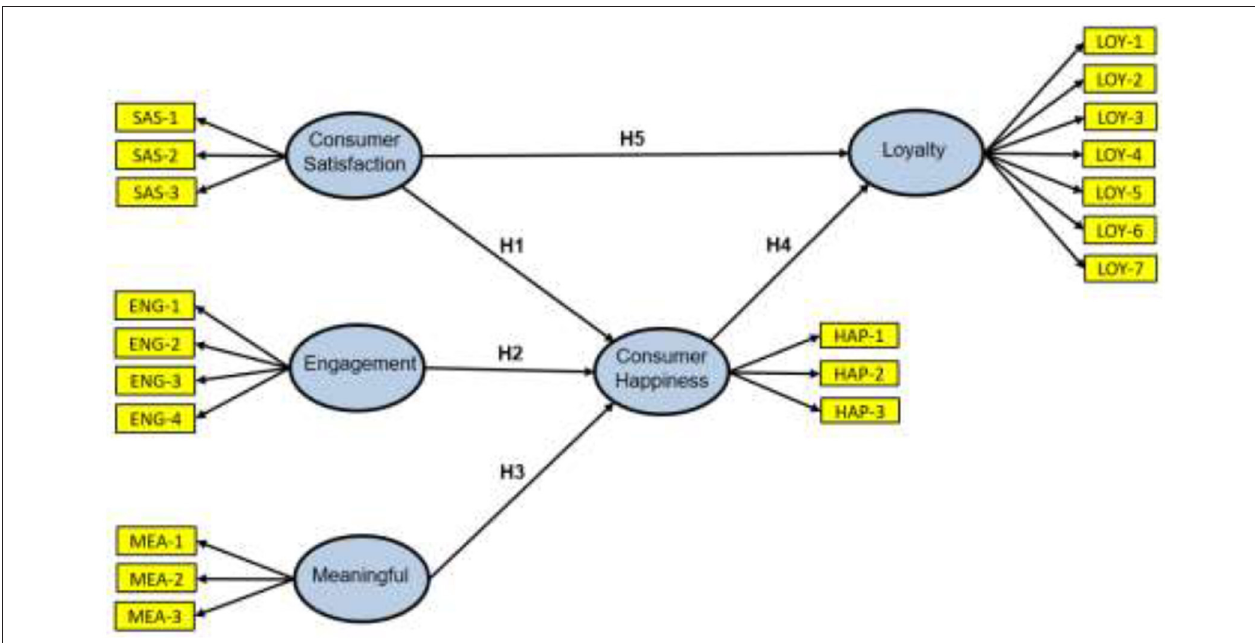
FIGURE 1 | Conceptual model and